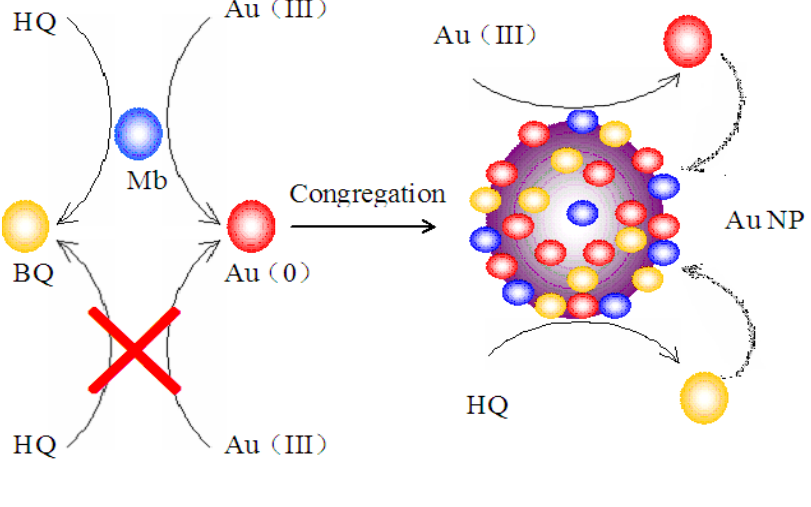
Figure 9. Proposed mechanism of Mb-mediated one-step synthesis of gold